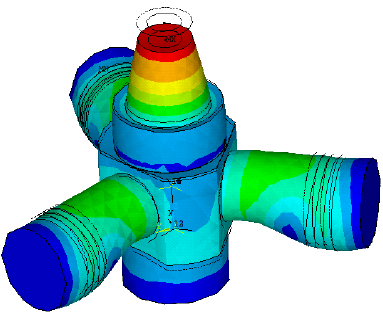
Figure 6. Longitudinal mode of the vibrator at 21.9 kHz.